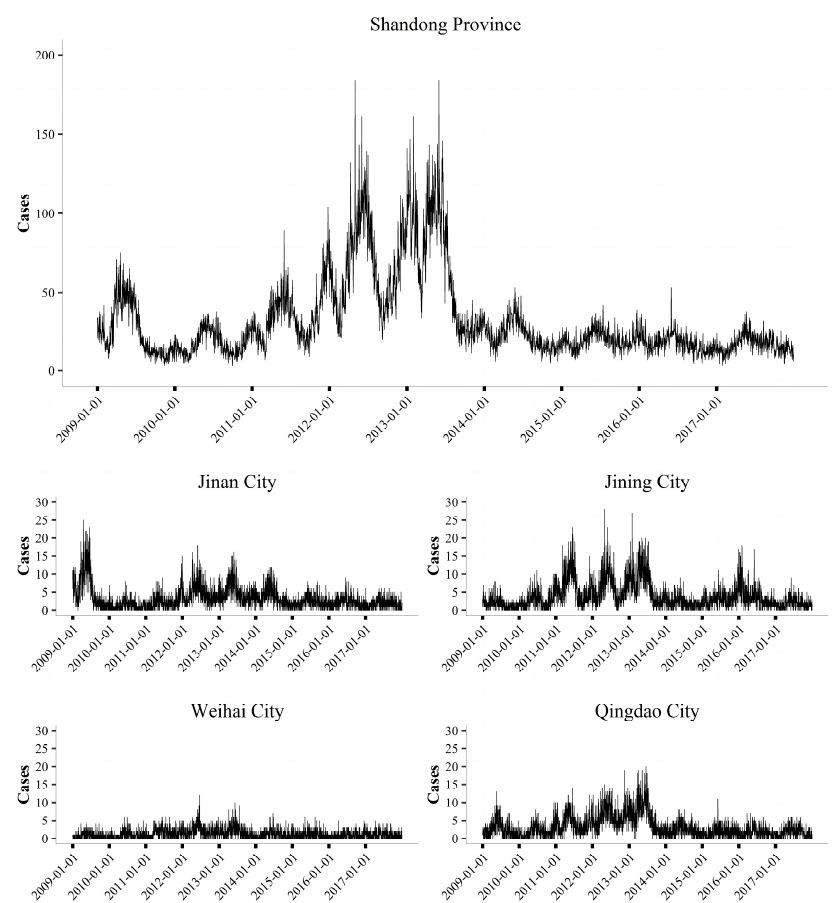
Figure 2. The daily cases of mumps from 2009 to 2017. The top panel represents the epidemic curve of Shandong Province, and the bottom panels represent the epidemic curves of Jinan City, Jining City, Weihai City, and Qingdao City, respectively. These four cities represent different regions of Shandong Province, China (inland and coastal cities). The epidemic curves of 17 cities are shown in the Supplementary Figure S1. Table 1. Daily average temperatures in Shandong Province and 17 cities from 2009 to 2017.